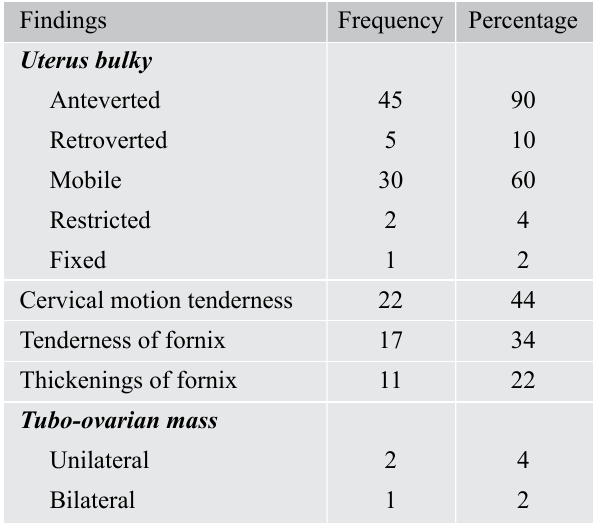
Table IV: Findings on bimanual examination of uterus